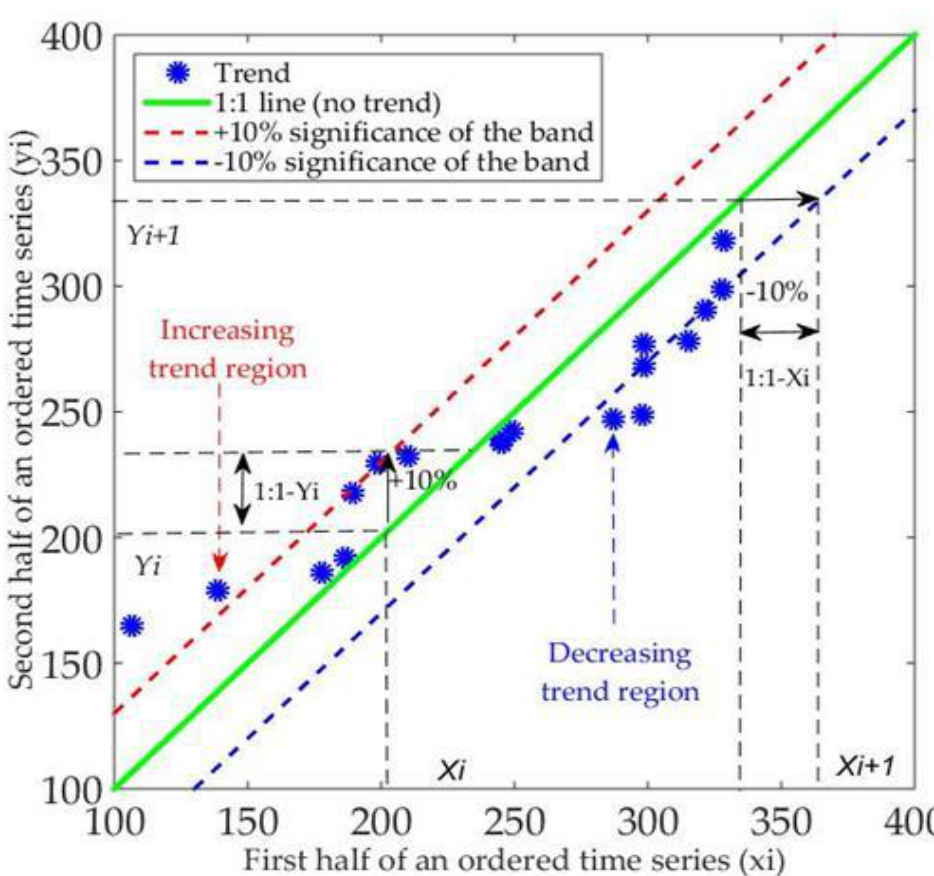
Figure 2. Paradigmatic illustrations of the ITA method.